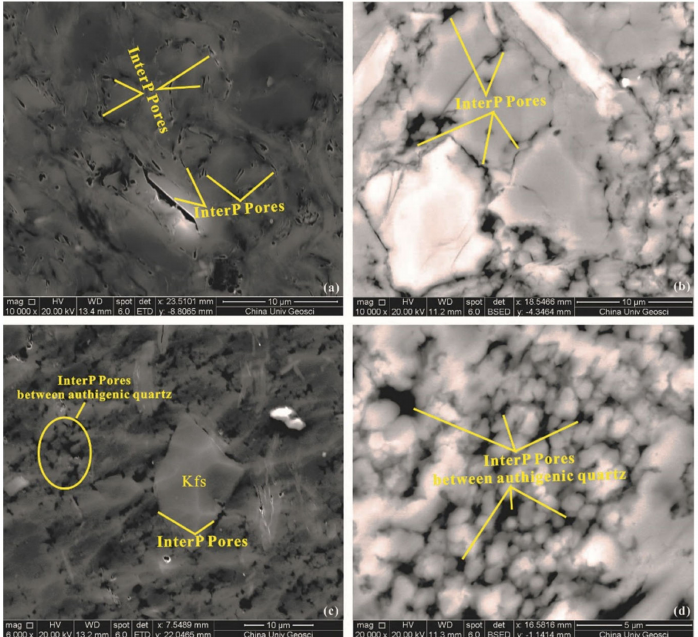
Figure 3. Interparticle pores between detrital grains and authigenic quartz. ( a ) InterP pores between clay minerals and rigid grains; ( b ) InterP pores between rigid grains; ( c ) InterP pores between K-feldspar and clay minerals; interP pores between authigenic quartz; ( d ) InterP pores between authigenic